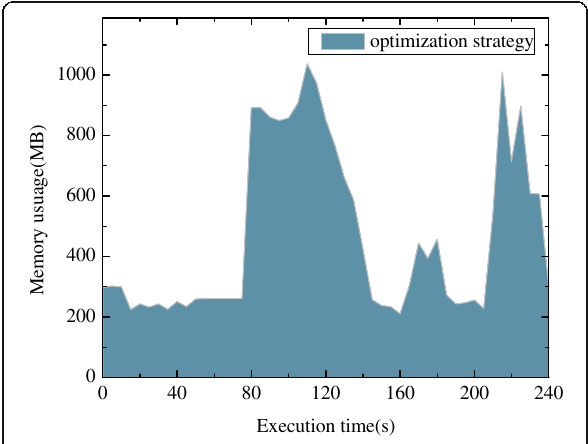
Fig. 6 The memory utilization of PageRank